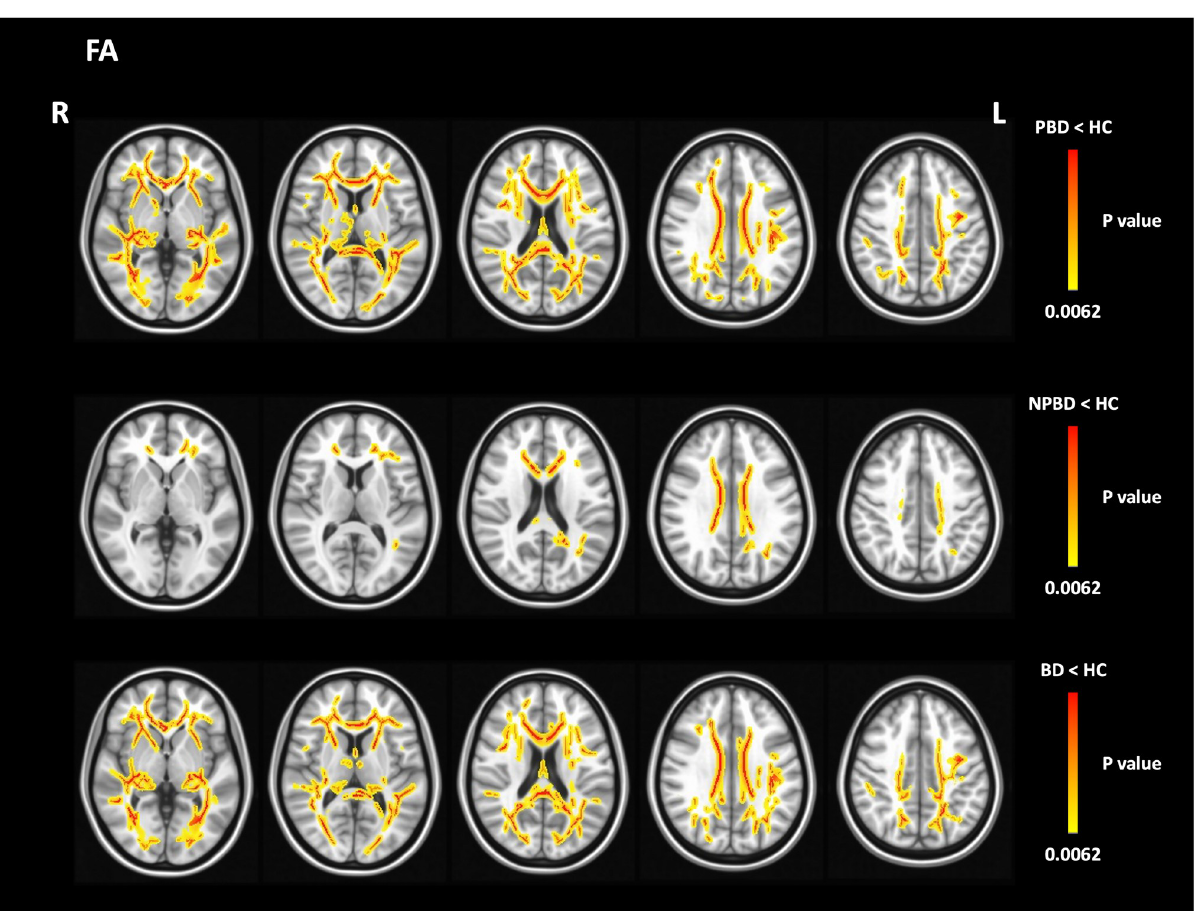
Fig 1. Tract-based spatial statistics analyses identified white matter areas affected by a significant decrease in fractional anisotropy (FA) in patients with psychotic bipolar disorder (PBD) (N = 29), non-psychotic bipolar disorder (NPBD) (N = 23), and bipolar disorder (BD) (N = 52) in comparisons with healthy controls (HCs) (N = 65). Family-wise error corrected P <